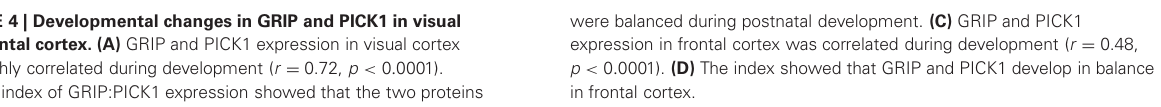
were balanced during postnatal development. (C) GRIP and PICK1 expression in frontal cortex was correlated during development ( r = 0.48, p < 0 . 0001). (D) The index showed that GRIP and PICK1 develop in balance in frontal